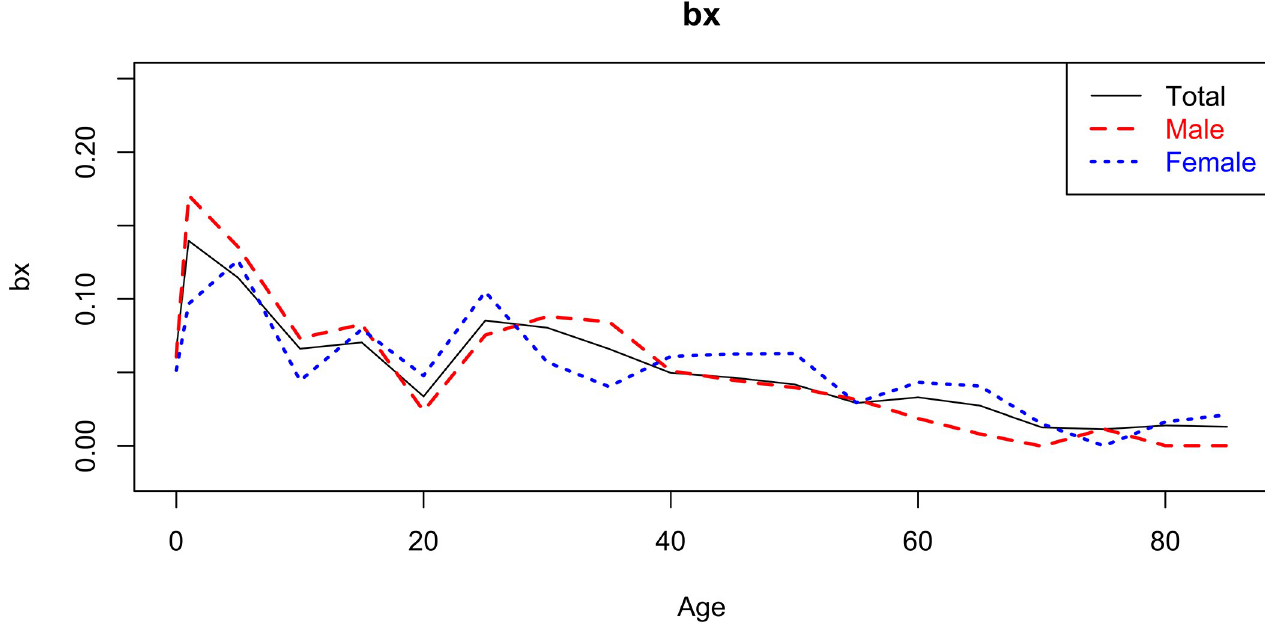
Fig 13. Estimate of bx, from the Lee-Carter model by sex for the total (2000–2018).